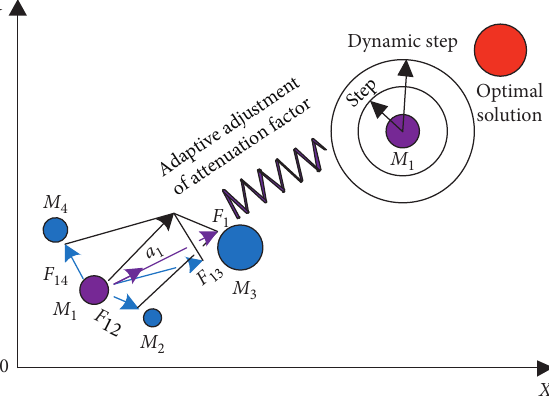
Figure 1: Schematic diagram of DGSA.